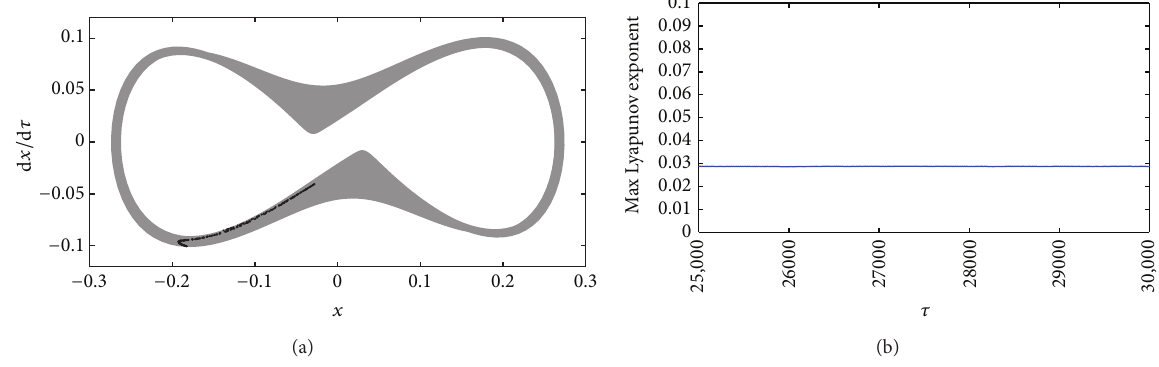
Figure 8: Response of the system with 𝜔 𝑒 = 12 Hz and 𝑍 𝑒 = 2.1𝑔 : (a) phase plot and Poincar´e section and (b) the max Lyapunov